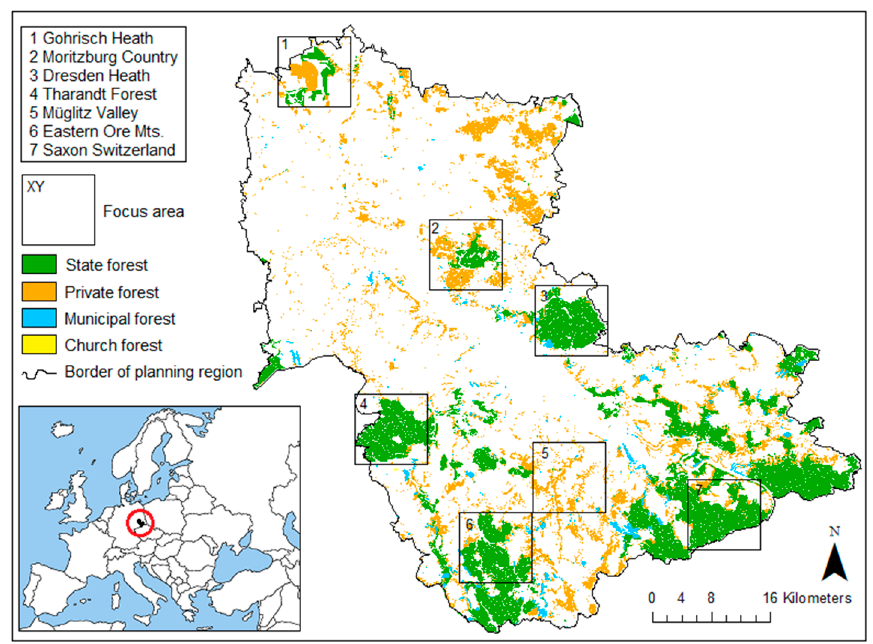
Figure 1. The planning district “Upper Elbe Valley/Eastern Ore Mts.”. Focus areas are highlighted. Only wood-producing areas are colored, whereas main ownership types are distinguished. Focus area 5 (Müglitz valley) serves as the case study area for in depth